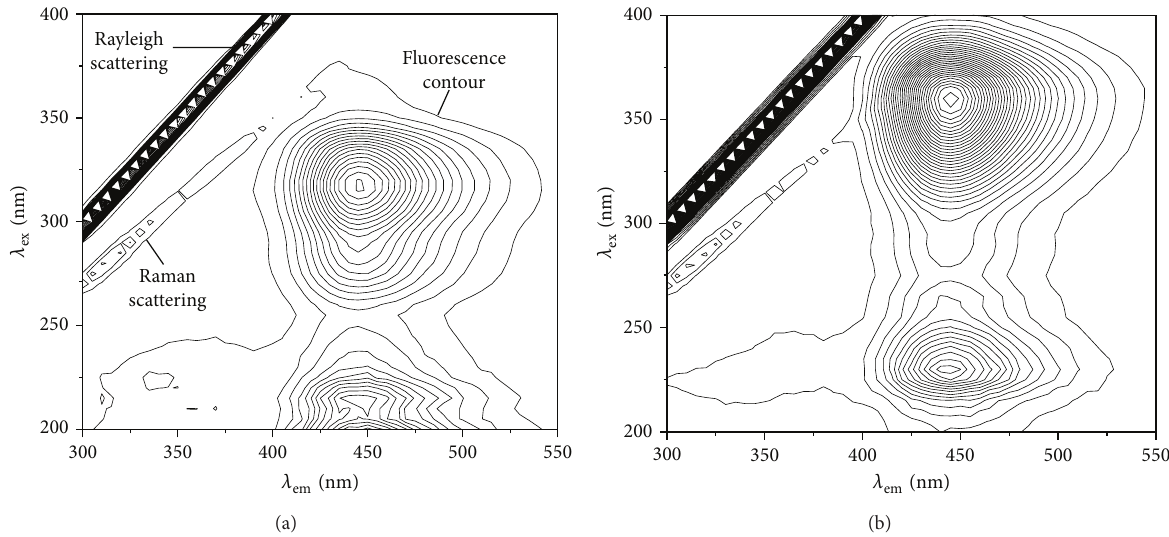
Figure 1: 3D fluorescence spectra of 4MU aqueous solution at different pH. 𝑐 4